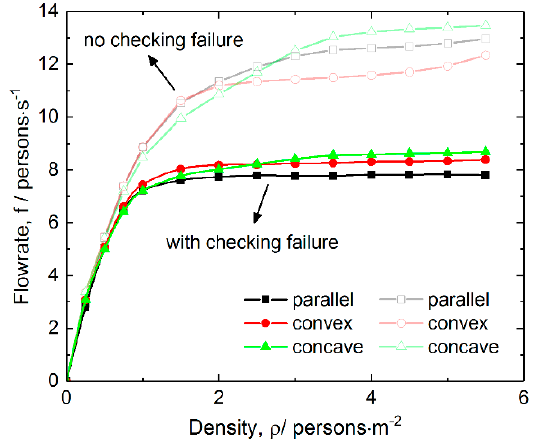
Figure 2. Total flowrate as a function of average pedestrian density in cases with and without checking failure for the three layouts of inspection points. The probability and average delay are 0.08 and 3 s, respectively.